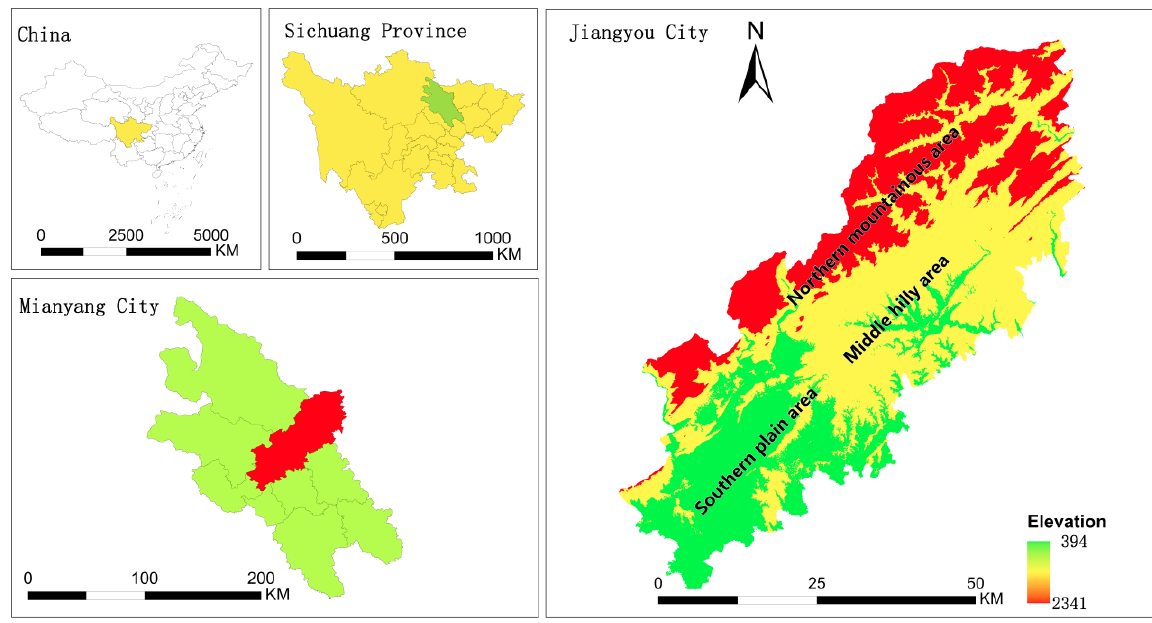
Figure 1. Location and topography of Jiangyou city.